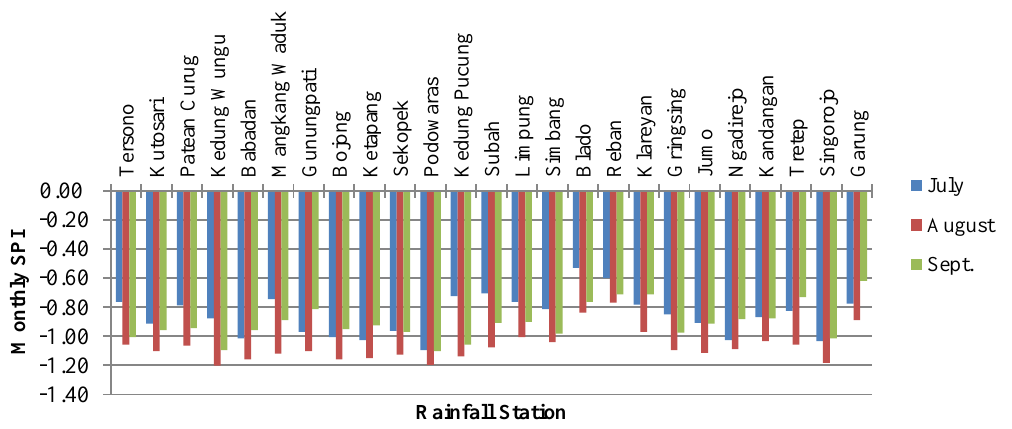
Figure 7. Frequency of rainfall stations experiencing moderately dry or worse conditions in the Bodri-Kuto river basin.